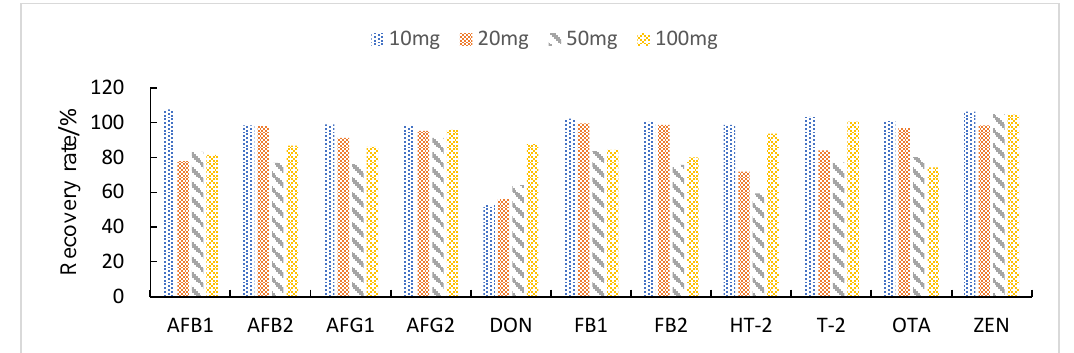
(b ) Figure 7. Comparison of maize extract before and after purification: (a) Before purification; (b) After purification. 3.4. Validation of the Proposed Method To evaluate the effectiveness of the method described here, its quantitative charac- teristics were considered under optimal conditions, including the LOD (S/N = 3), LOQ (S/N = 10), and precision (expressed as the relative standard deviation). The results are presented in Tables 4 and 5. Table 4. Linear equations and regression coefficients of the matrix-matched standard calibration curves ( n = 3). Feed Matrix